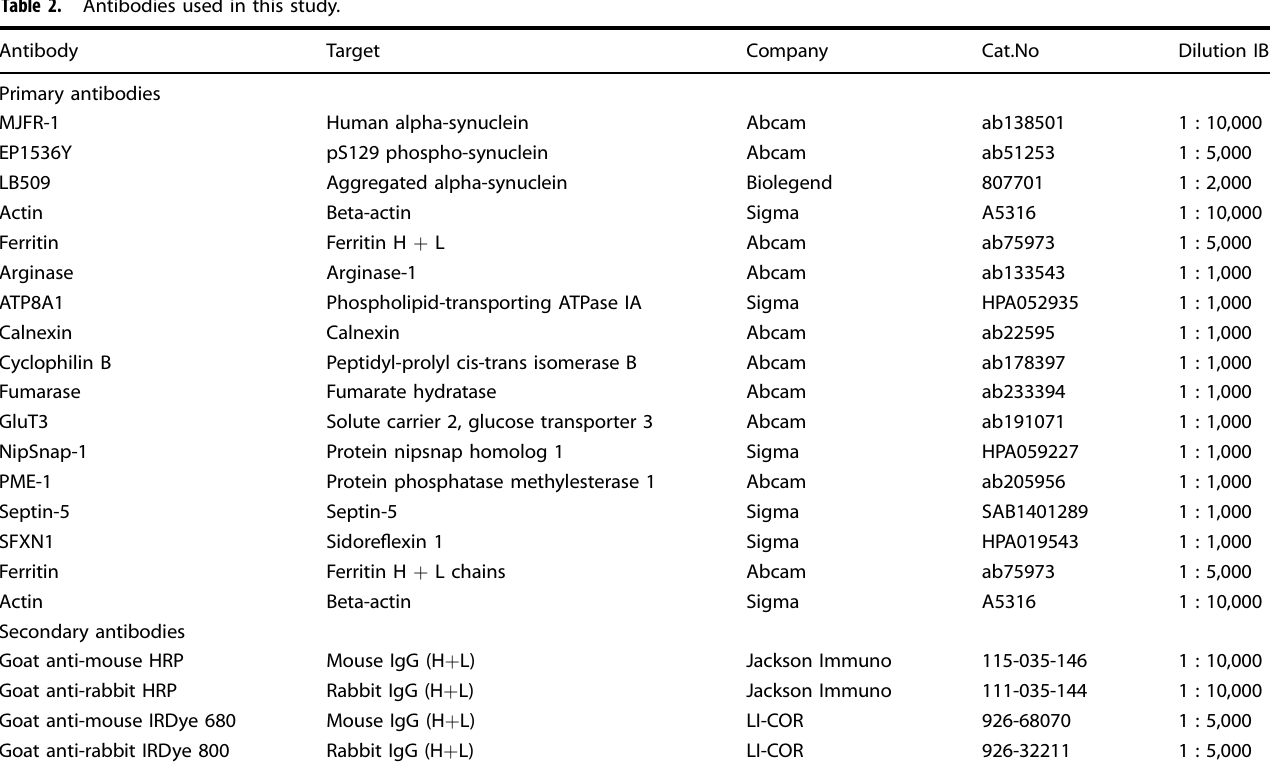
Table 2. Antibodies used in this